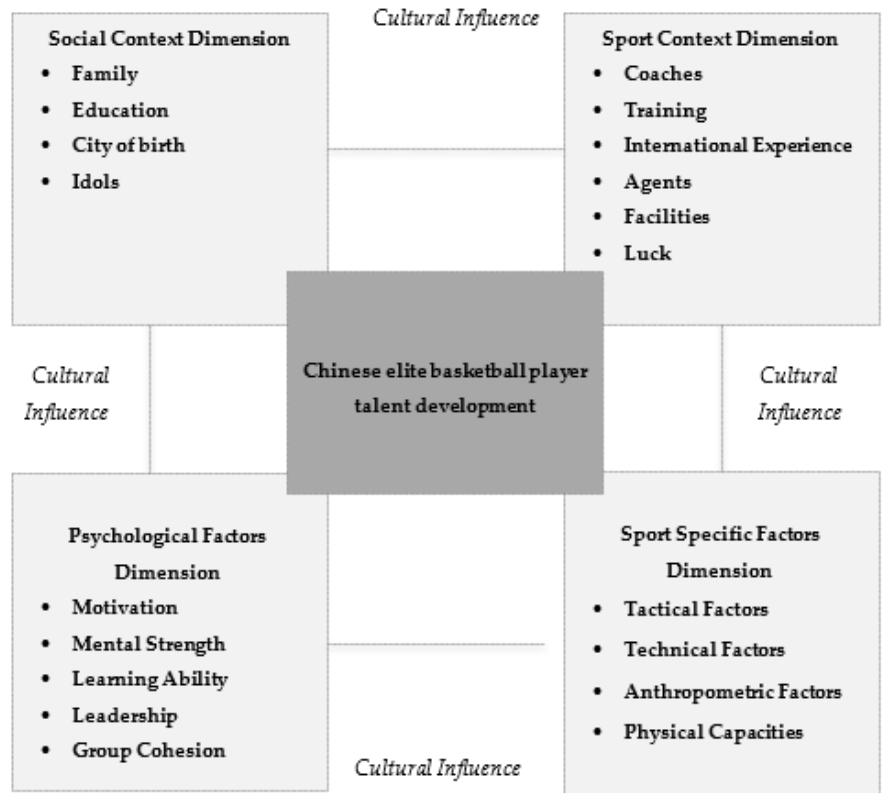
Figure 2. Qualitative data analysis: dimensions affecting talent development of elite basketball players in China.